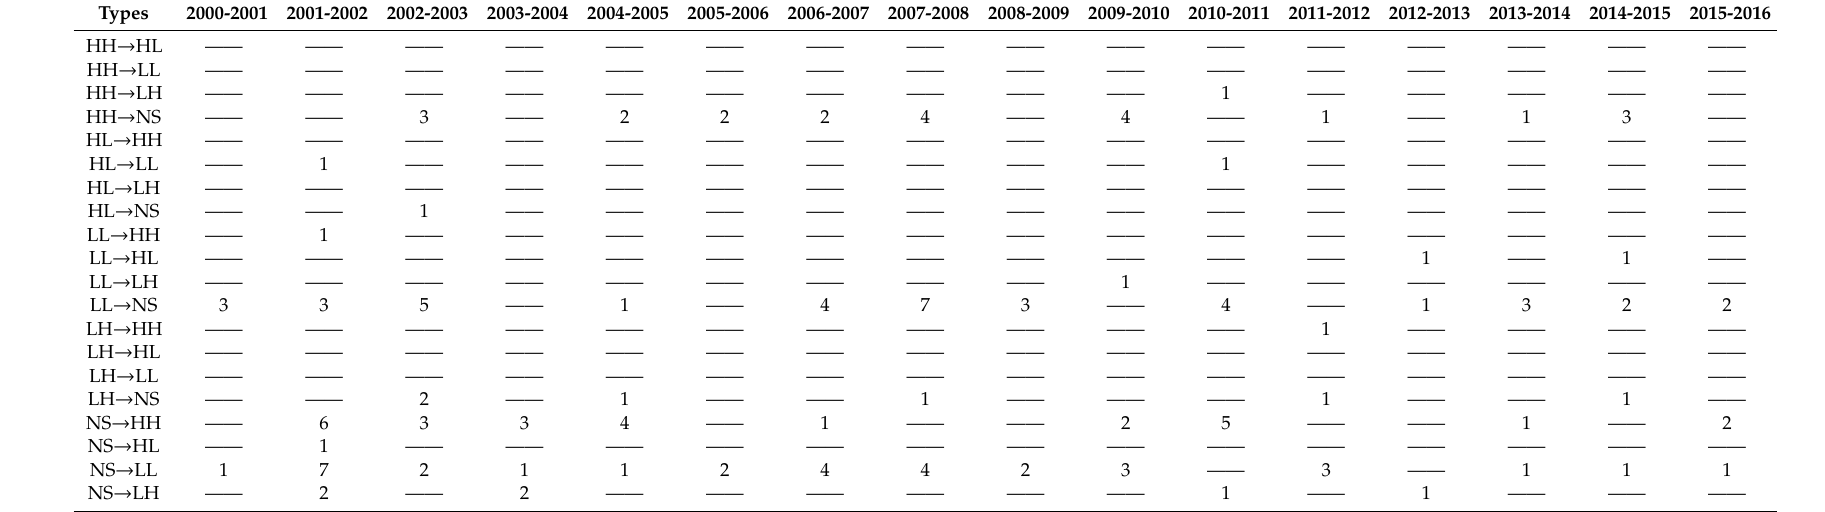
Table 6. Transfer path of spatial agglomeration on agricultural land use intensity in Hubei Province from 2000 to